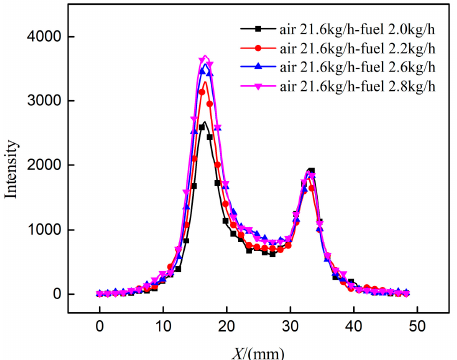
Figure 19. The influence of fuel mass rate on fuel distribution at a distance of 5 mm from the swirler exit in the y -direction (Case B).